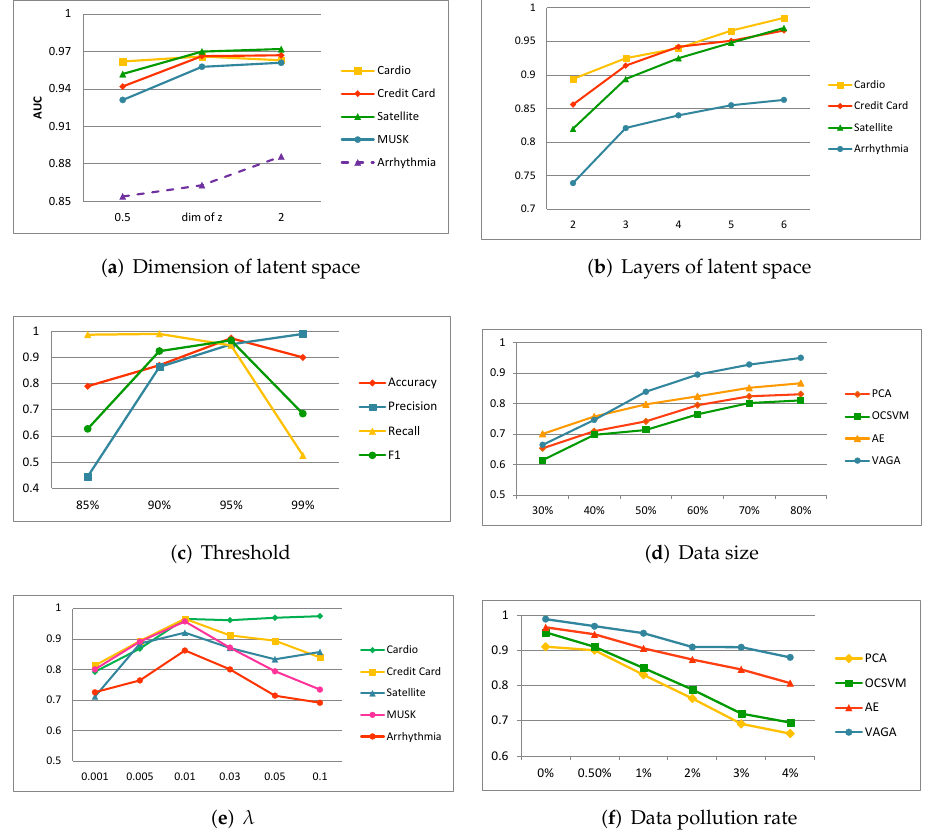
Figure 10. The effect of tuning important parameters on model